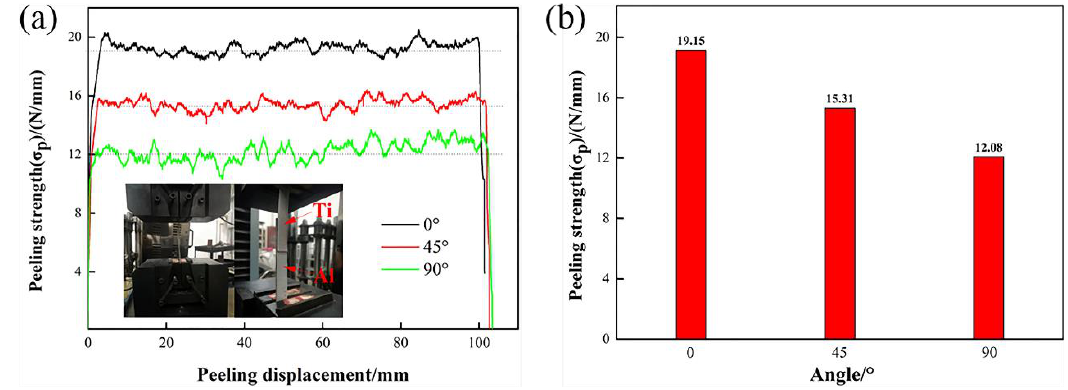
Figure 10. The results of the peel test. ( a ) peeling strength-displacement curves of the composites, ( b ) peeling strength with different angle of the composites. ( b ) peeling strength with di ff erent angle of the